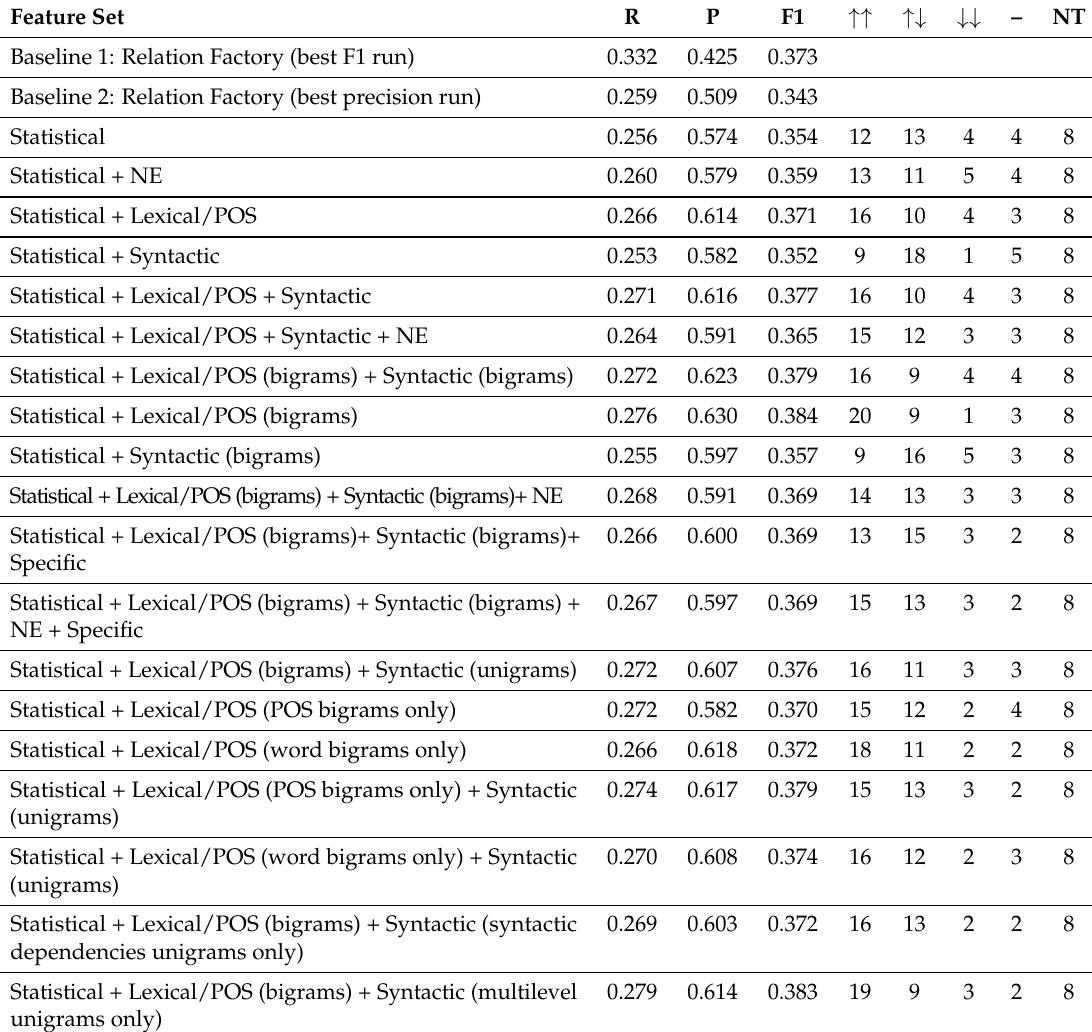
Table 7. Results obtained by Relation Factory using the TAC KBP 2013 Slot Filling scorer on the test dataset after filtering when using different feature